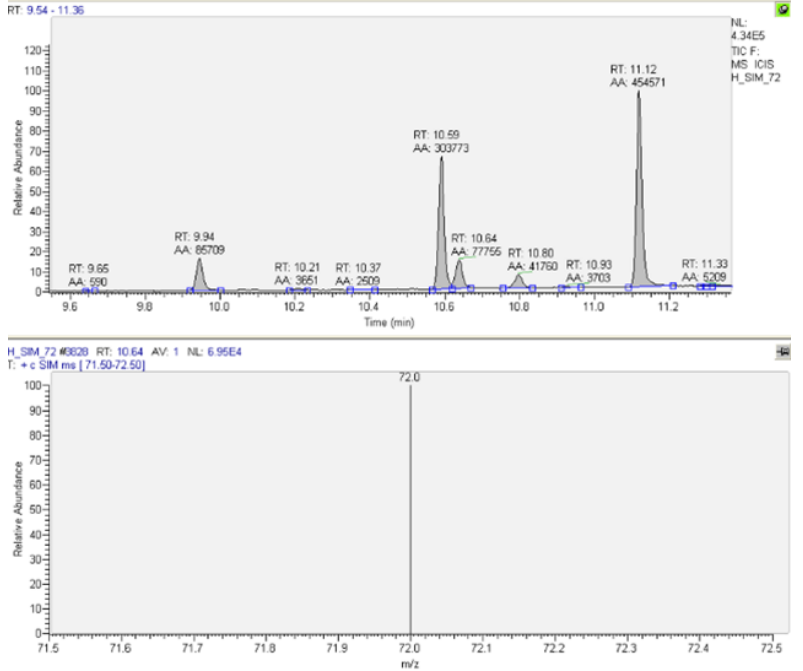
Figure 4. Typical chromatogram and MS spectrum for methadone determination in patients’ plasma sample—SIM (t R = 10.64, m/z = 72), Patient 2.